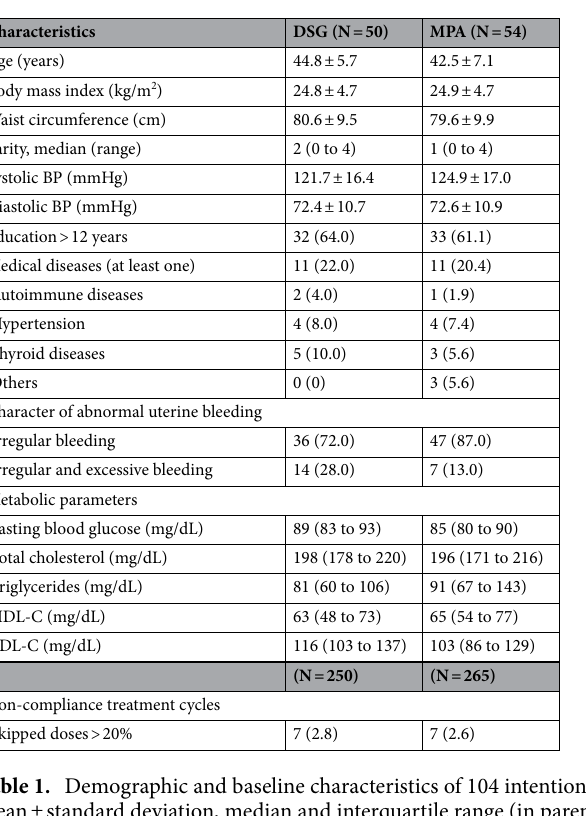
parentheses), otherwise specified. BP blood pressure, DSG desogestrel, HDL-C high-density lipoprotein cholesterol, LDL-C low-density lipoprotein cholesterol; MPA, medroxyprogesterone acetate.